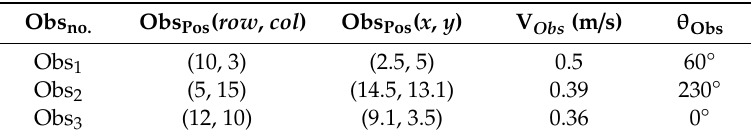
Table 3. Grid-based dynamic environment 1 setting.